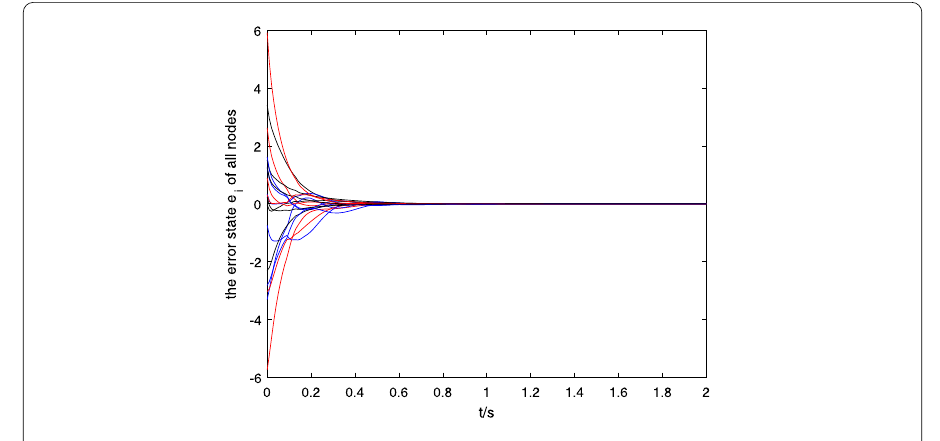
Figure 6 The error state e i of all nodes when h 1 = 8, h 2 = 6, h 3 = 8, h 4 = 10 and θ =